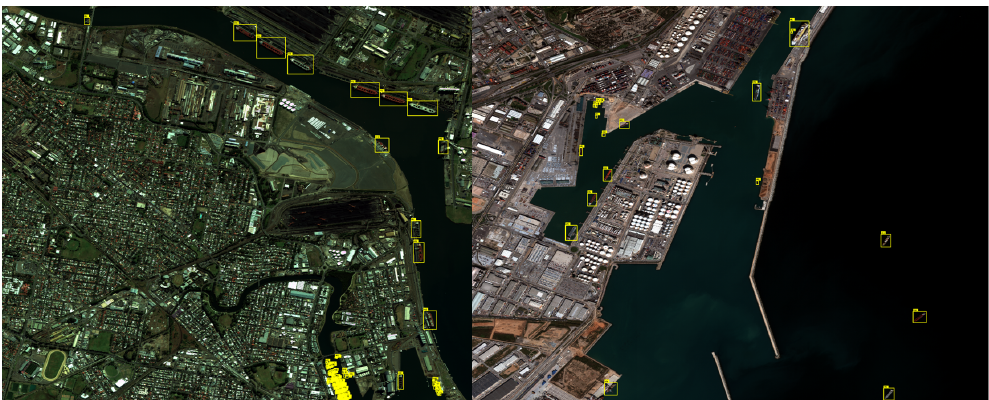
Figure 2. Examples of large-scale remote sensing images containing sparsely distributed ship objects. The groundtruth bounding boxes are plotted in yellow color. These WorldView-3 images are provided by DigitalGlobe